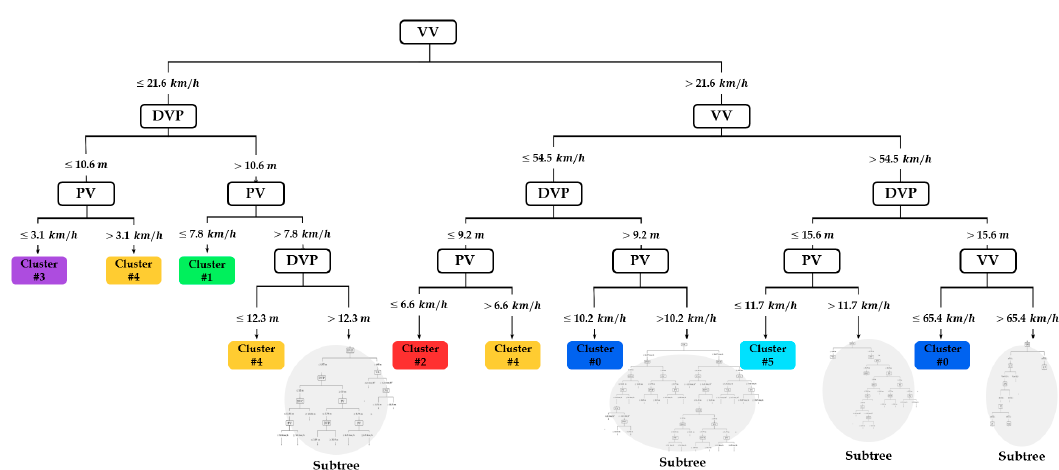
Figure 13. Result of decision tree (no pruning).